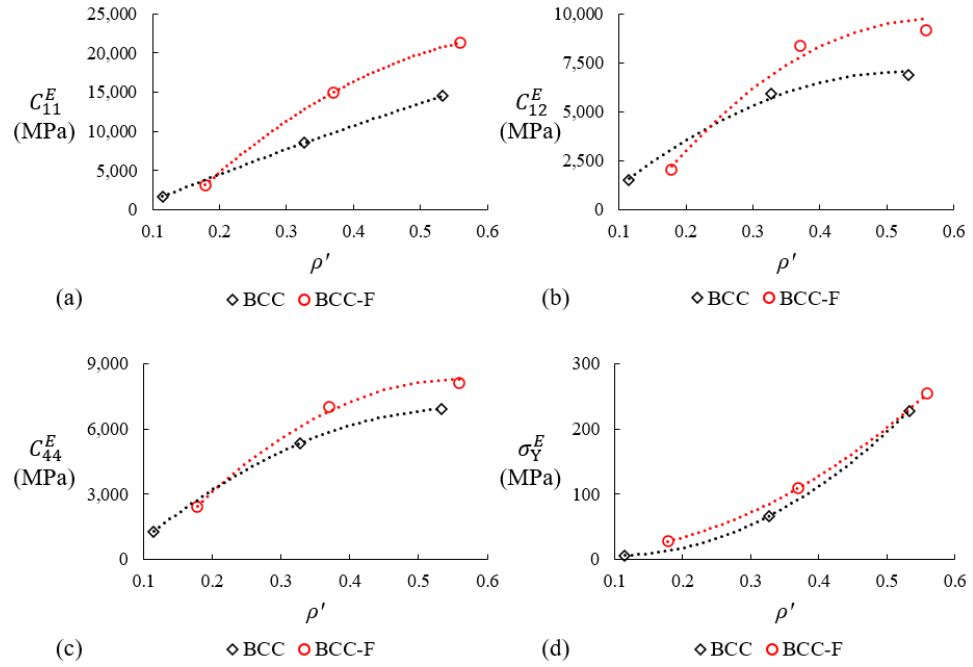
Figure 12. Relationship between the relative density, 𝜌 (cid:4593) , and the effective material properties of ( a ) 𝐶 (cid:2869)(cid:2869)(cid:3006) , ( b ) 𝐶 (cid:2869)(cid:2870)(cid:3006) , ( c ) 𝐶 (cid:2872)(cid:2872)(cid:3006) , and ( d ) 0.2% offset yield stress, 𝜎 (cid:3026)(cid:3006) , of the BCC and the BCC-F lattices. Symbols represent the properties measured and calculated at specific density levels and dashed lines repre- sent the plots of second-order polynomial surrogate models fitting the symbols.